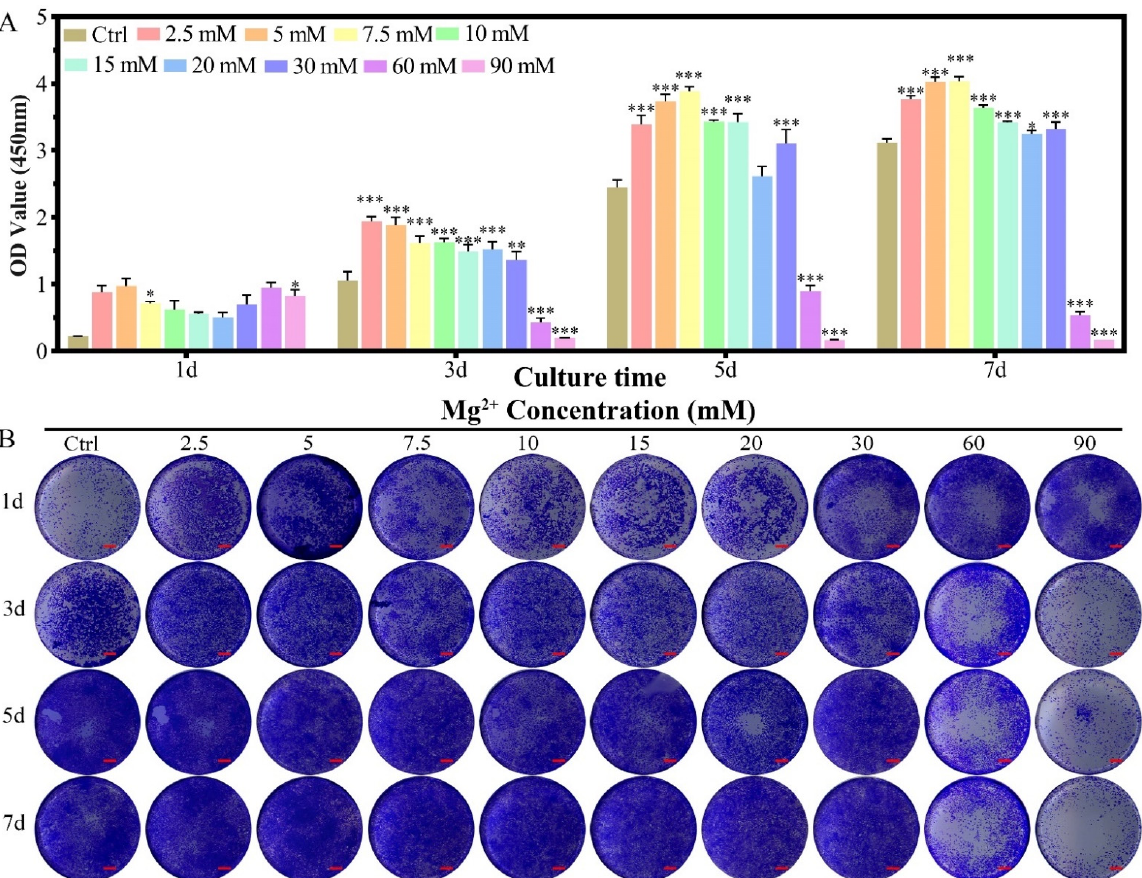
Figure 5. The proliferation of MC3T3-E1 cells cultured in varied Mg 2+ concentrations from 0.8 mM (Ctrl group) up to 90.0 mM. ( A ) the CCK-8 quantitative method of the cell proliferation, all data were presented as mean ± SD, * p < 0.05, ** p < 0.01, and *** p < 0.001; ( B ) digital graphs of the crystal violet stained MC3T3-E1 cells cultured in different Mg 2+ containing culture medium, scale bar = 1 mm.